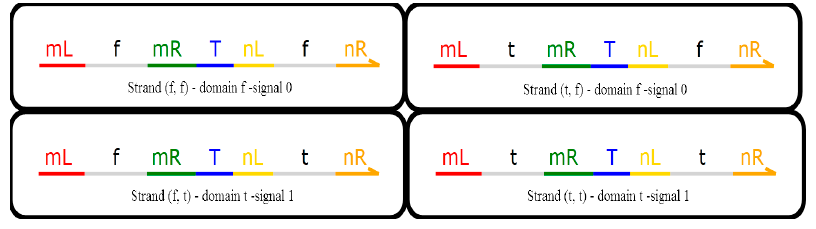
Figure 2. Domain f and domain t.